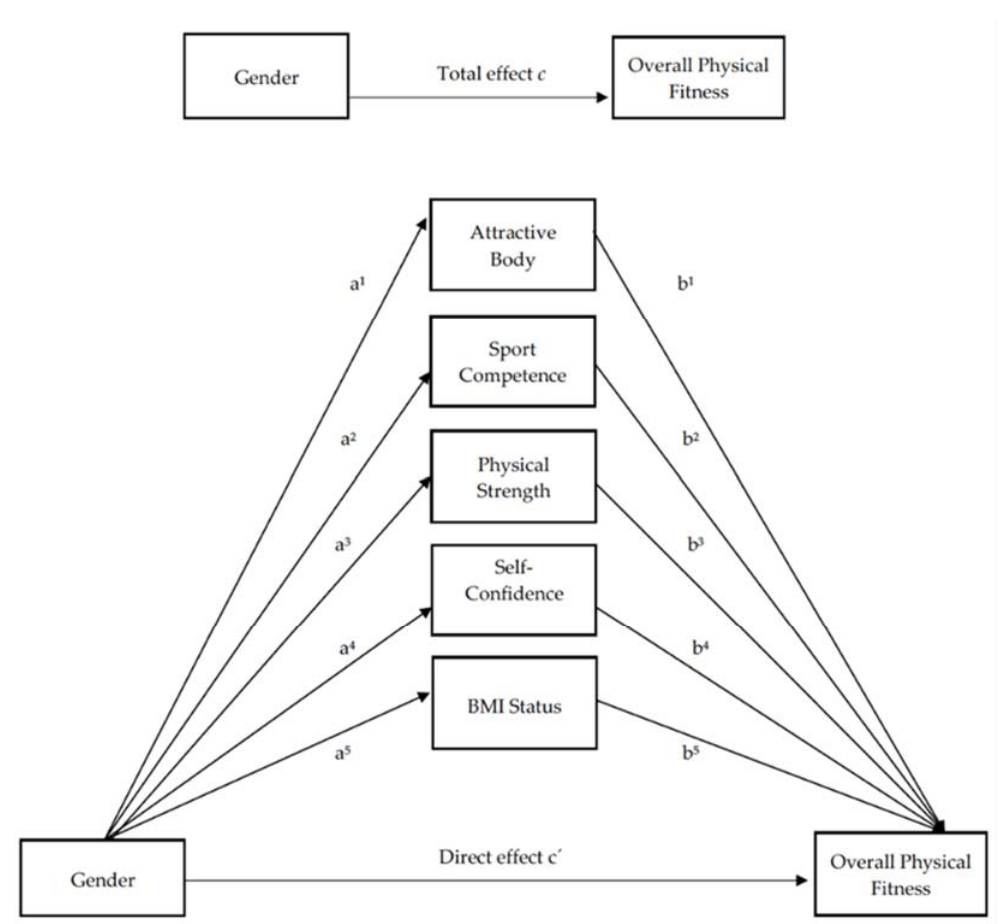
Figure 1. Hypothetical model of the relationship between gender and overall physical fitness.